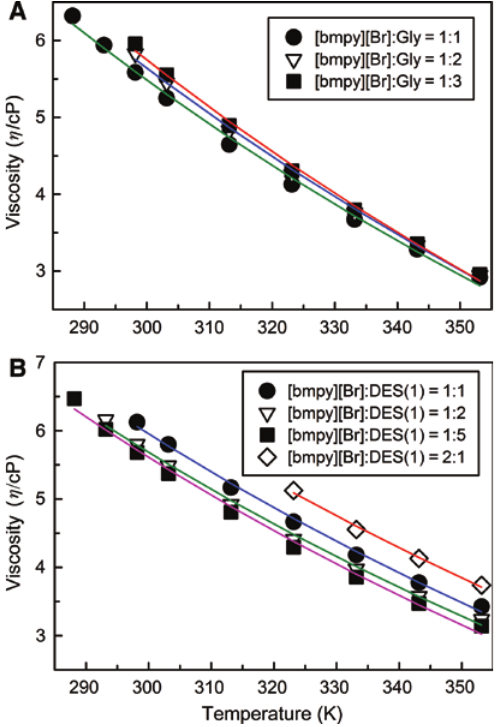
Figure 6: Densities of the binary and ternary mixtures based on [bmpy][Br] molar fraction. Error bars are smaller than the data points in the